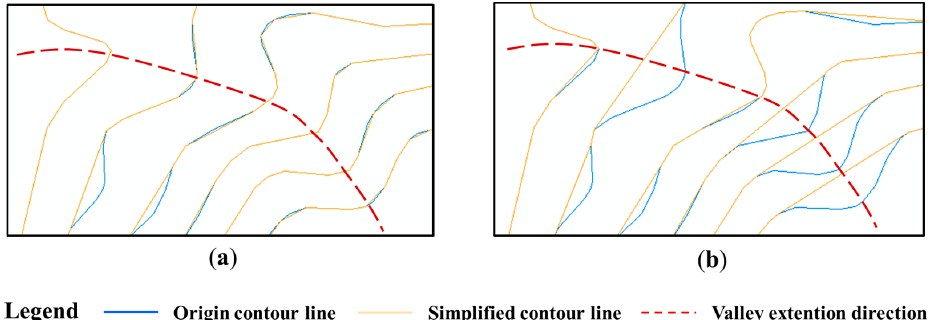
Figure 16. Local simplification results of: ( a ) the proposed method; ( b ) the bend selection algorithm. To assess the effectiveness of our proposed method, we compared its results with those of manual simplification (Figure 17). The yellow lines in the figure are the contour lines obtained by manual simplification and the blue lines are the inconsistencies identified using the simplification method proposed in this study. We used the visual buffer tolerance method [35] to quantitatively assess the similarities between the two methods, with 0.2 mm on the map as a radius to establish a buffer zone for the contour lines obtained by manual simplification. The visual buffer tolerance was defined as the ratio of the length of a contour line in the buffer zone obtained by our proposed simplification method to its total length. The buffer tolerance of the two results was calculated as 97.37%, indicating that the contour lines obtained using the two methods were highly similar. The manual process considers more complex factors such as the density of terrain structures and their relationship, whereas our proposed method only considers the characteristics of the valley bend group, leading to some differences in the simplification results. In the areas where the valleys are relatively dense, more valley bend groups were deleted using manual processes than using our proposed methods, and vice versa. In this way, the ratio of the valley densities can be maintained after simplification using manual processes. In the enlarged image in Figure 17, the two red dotted lines are the direction of two valleys of a saddle. The method in this study deleted the bend group of one of the valleys and failed to consider the relationship between the two valleys.